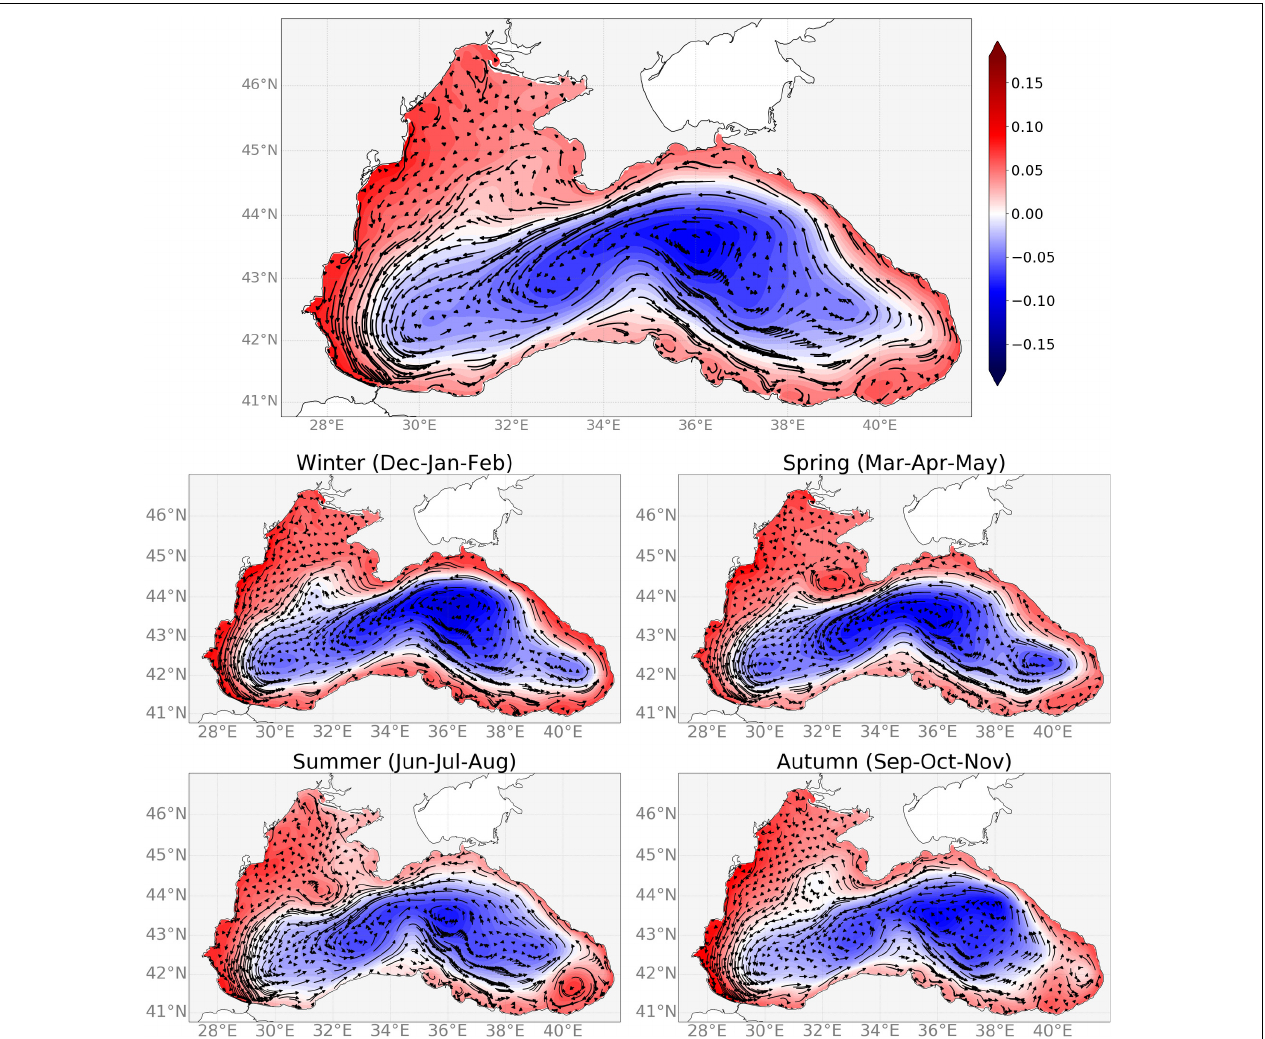
FIGURE 12 | Mean sea surface height and 100 m depth average velocity derived from the BS-REA evaluated for the whole period 1993-2018 (top panel) and each season considering the climatological period